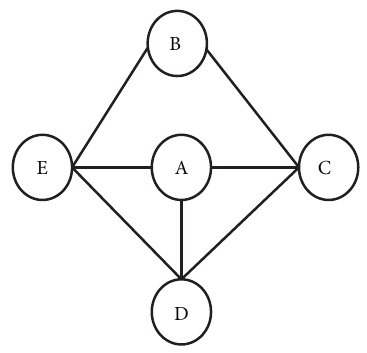
Figure 2: Airspace sector